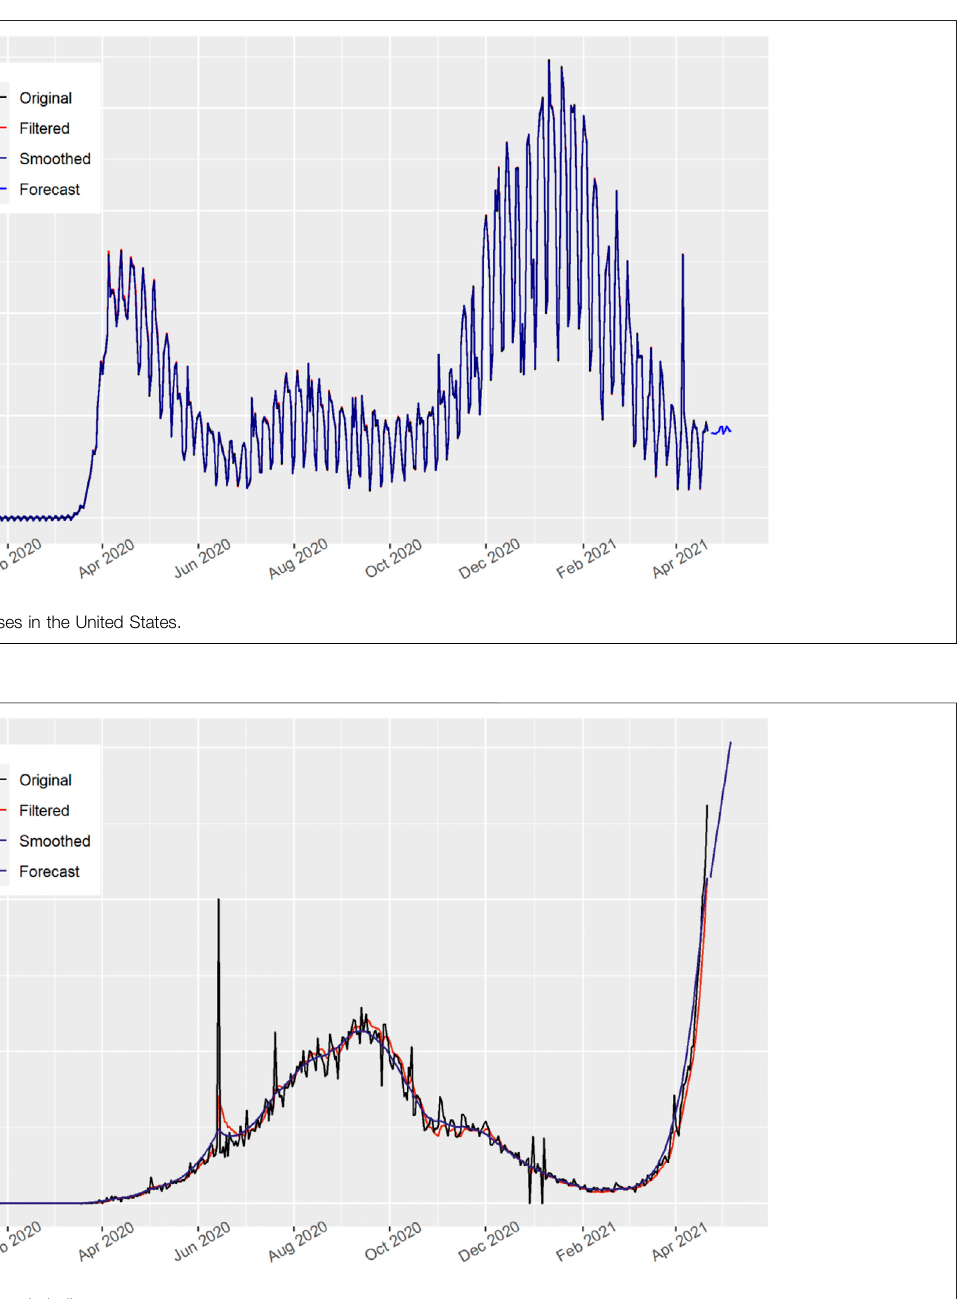
FIGURE 6 | Number of daily death cases in